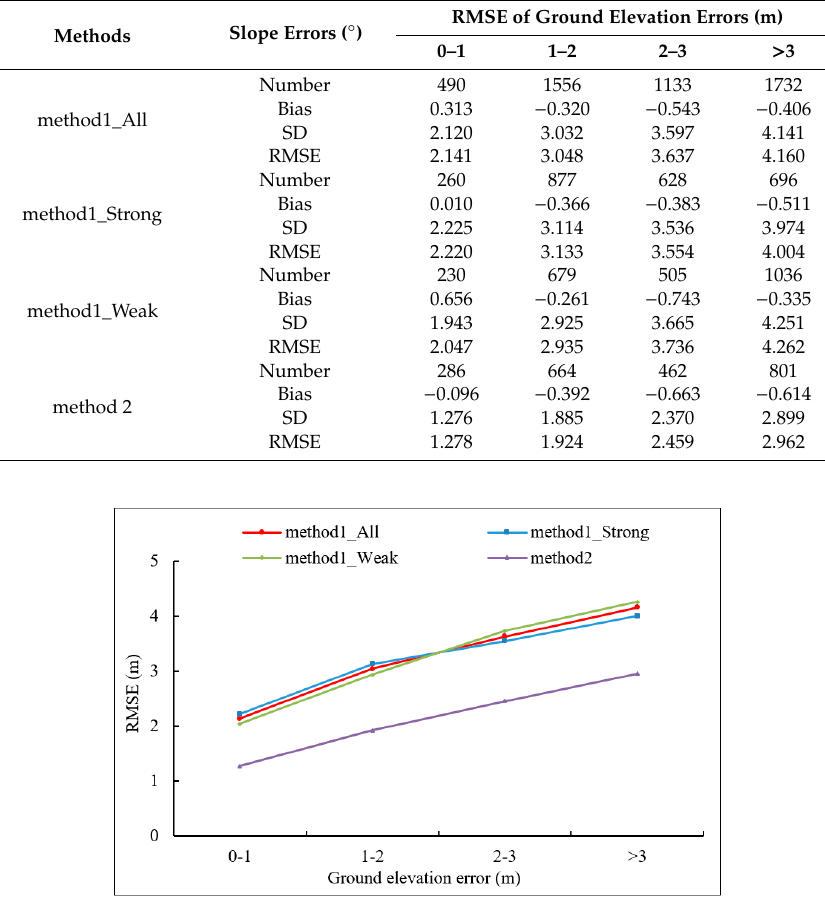
Table 6. Statistical errors of different methods, classified by ground elevation error.